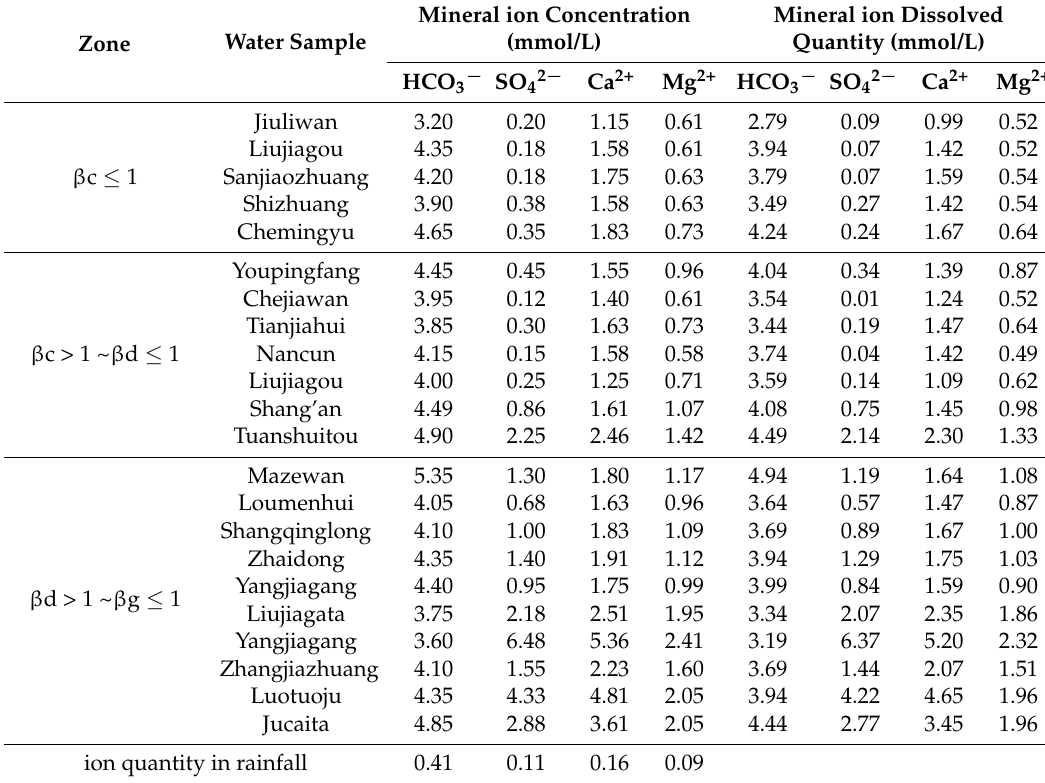
Table 1. Mineral ion concentration and the dissolved quantity of each water sample point. Mineral ion Concentration Mineral ion (mmol/L) Zone Water Sample